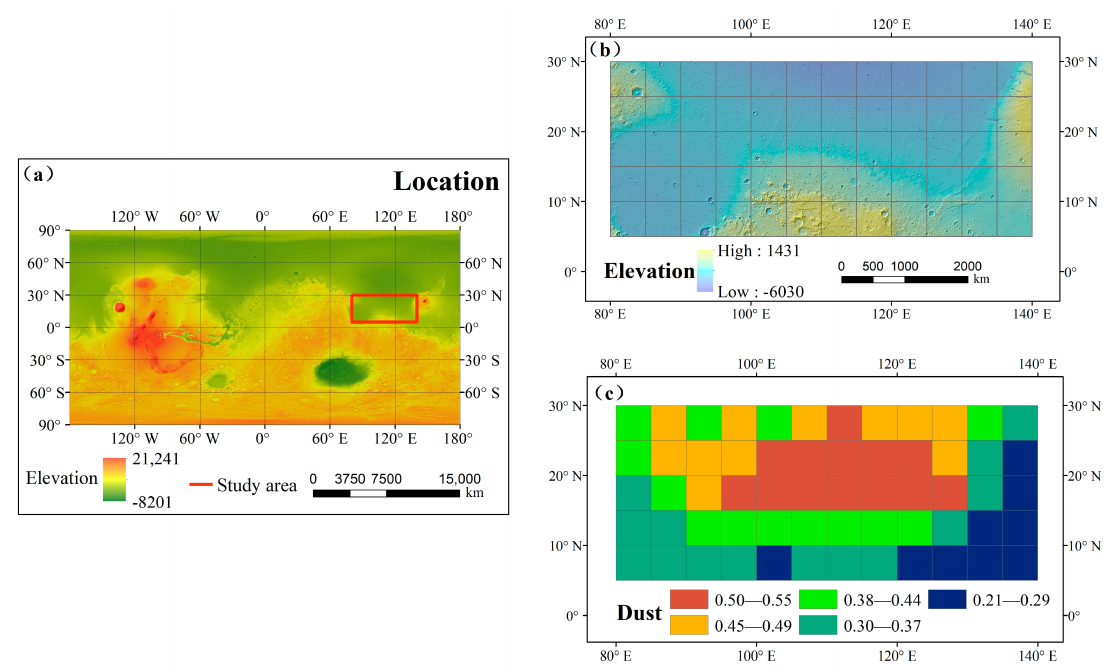
Figure 1. The location of the study area ( a ), the elevation distribution ( b ), and the average dust distribution ( c ) during sol 81–111 from Martian year 29 to 32 across the study